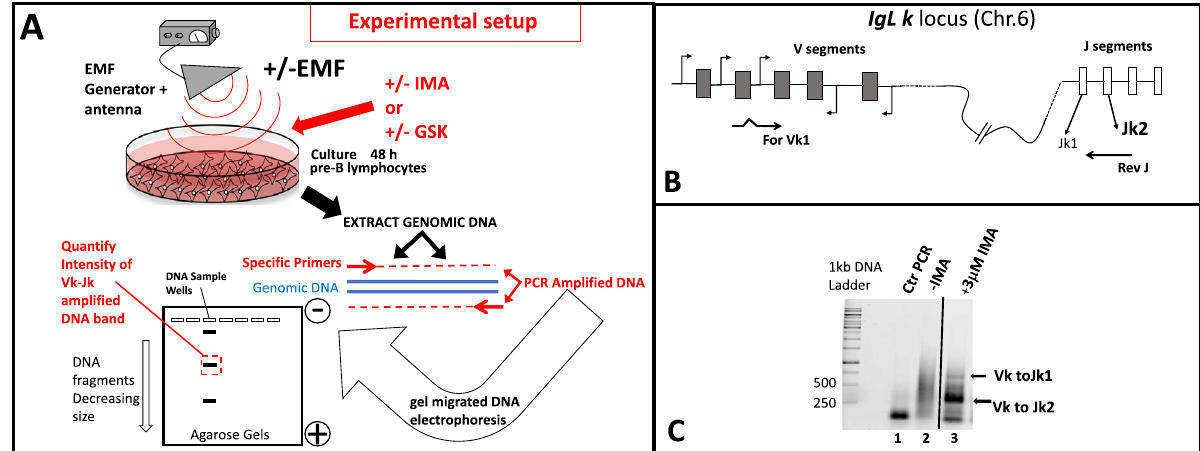
Figure 1. ( A ) Schematic depiction of the flow chart of the experimental design. Murine A-70 vAbl pre-B cells grown with or without exposure to Electromagnetic field influence(EMF), in the absence or presence of RAG stimulation either by Mesylate of Imatinib (IMA) or by GSK-690693(GSK), are harvested and their genomic DNA subjected to a two-steps PCR recombination assay identifying Vk to Jk rearrangements at their IgL kappa loci. The electrophoretically separated recombination products (Vk-Jk) are quantified by densitometry to assess the extent of locus rearrangements influenced by EMF. ( B ) Shematic configuration of IgL k kappa locus on Mouse chromosome 6, and the positioning of the primers used in the assay. ( C ) PCR reactions electrophoretically separated in agarose gel stained with Sybr green identify the recombined products (arrows show Vk to Jk1 and Vk to Jk2) in lane 3 versus, control reactions lane 1 without genomic DNA, lane 2 templating genomic DNA from uninduced cells (in germline configuration). Such recombination amplified reactions are then used for densitometry quantifications. The entire gel from which ( C ) was cropped displaying amplifications (Vk to Jk response) from cells treated with a wide range of increasing IMA concentrations , is shown in Supplemental Material Fig. 3Sa.